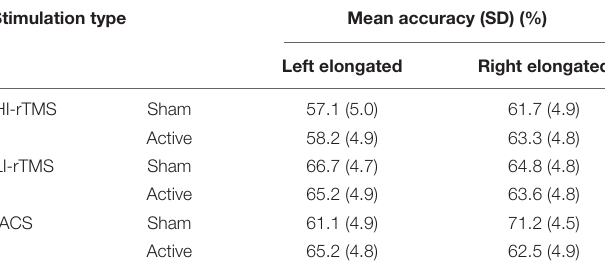
TABLE 1 | Mean accuracy (%) when responding to transected line stimuli in the line bisection